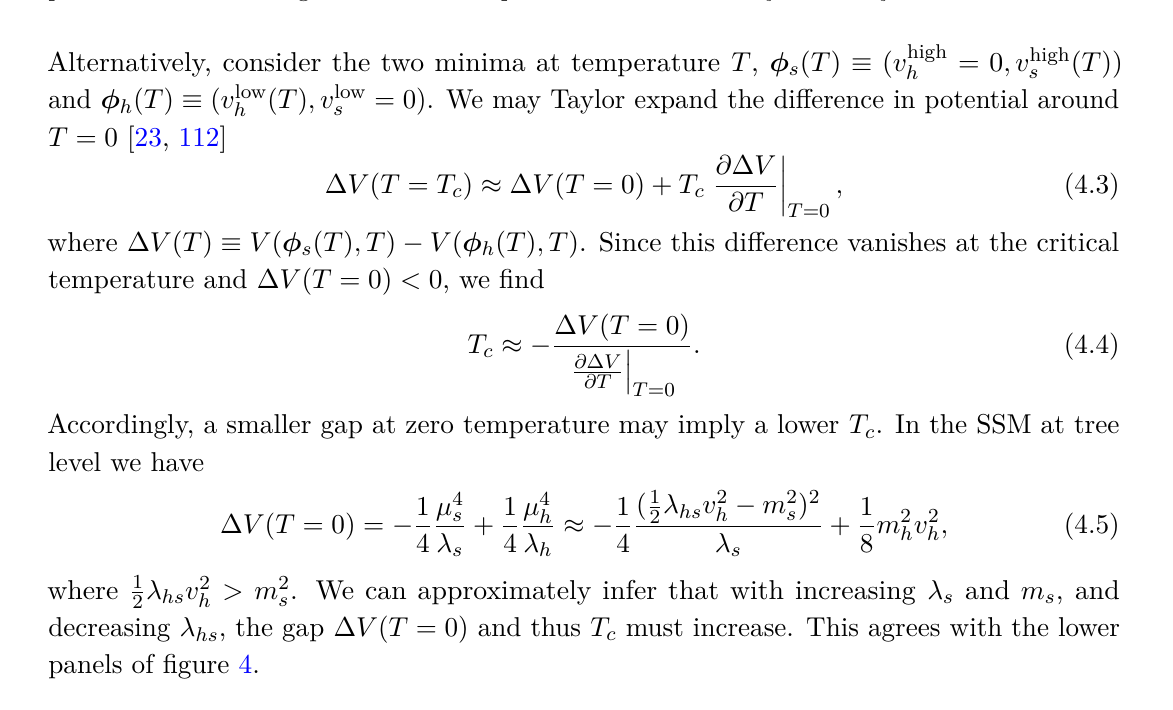
( ξ = 0) displayed in the lower c